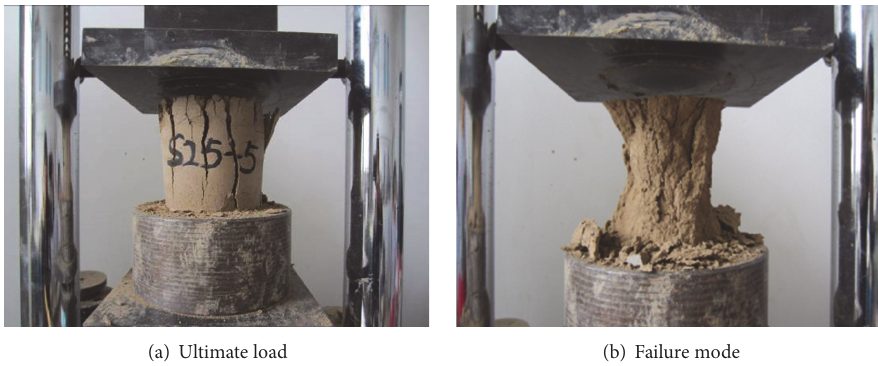
Figure 4: Sand soil specimens.